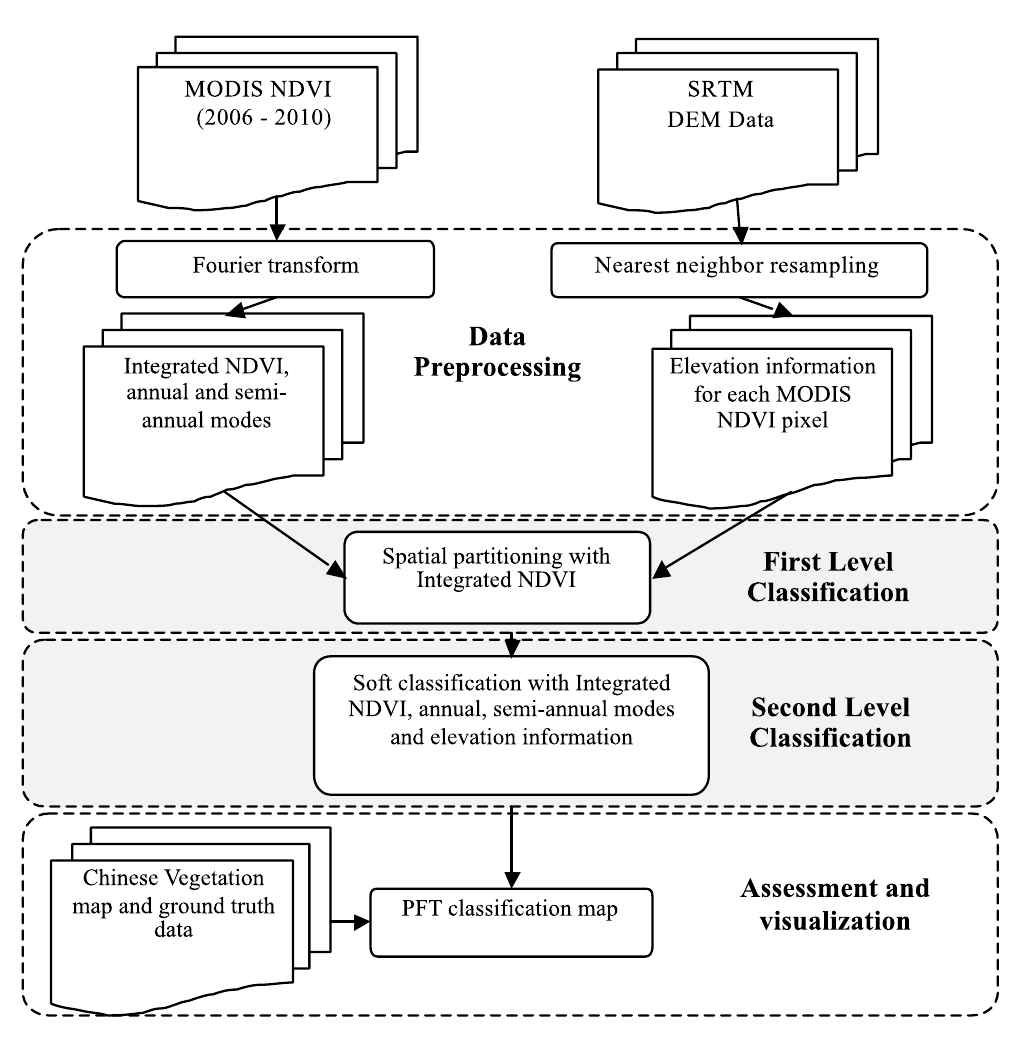
Figure 7. Flowchart of the overall approach applied in Tibetan